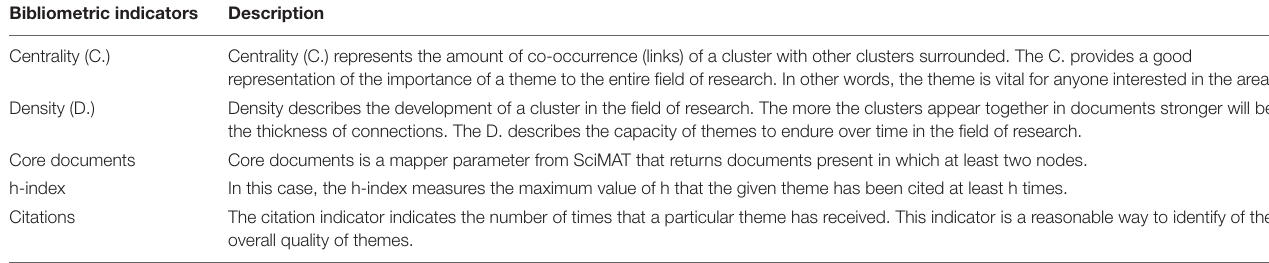
TABLE 3 | Bibliometric indicators used in this research. Bibliometric indicators Description Centrality